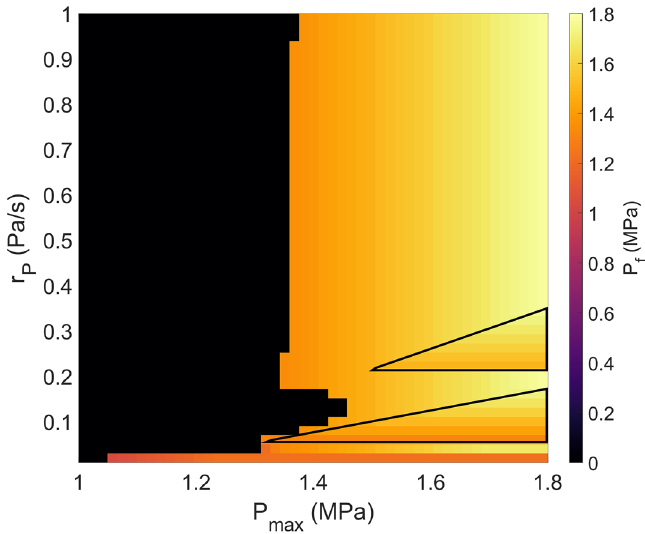
Figure 4. Variation of pore pressure threshold between purely aseismic and combined seismic and aseismic response on the fault. P t (color scale) vs P max and r P . The black region is category 1, where the threshold is zero because there are no triggered earthquakes. The yellow to orange region is Category 2. For clarity, triangular boundaries have been made to highlight the regions within the model space that are dependent on r P